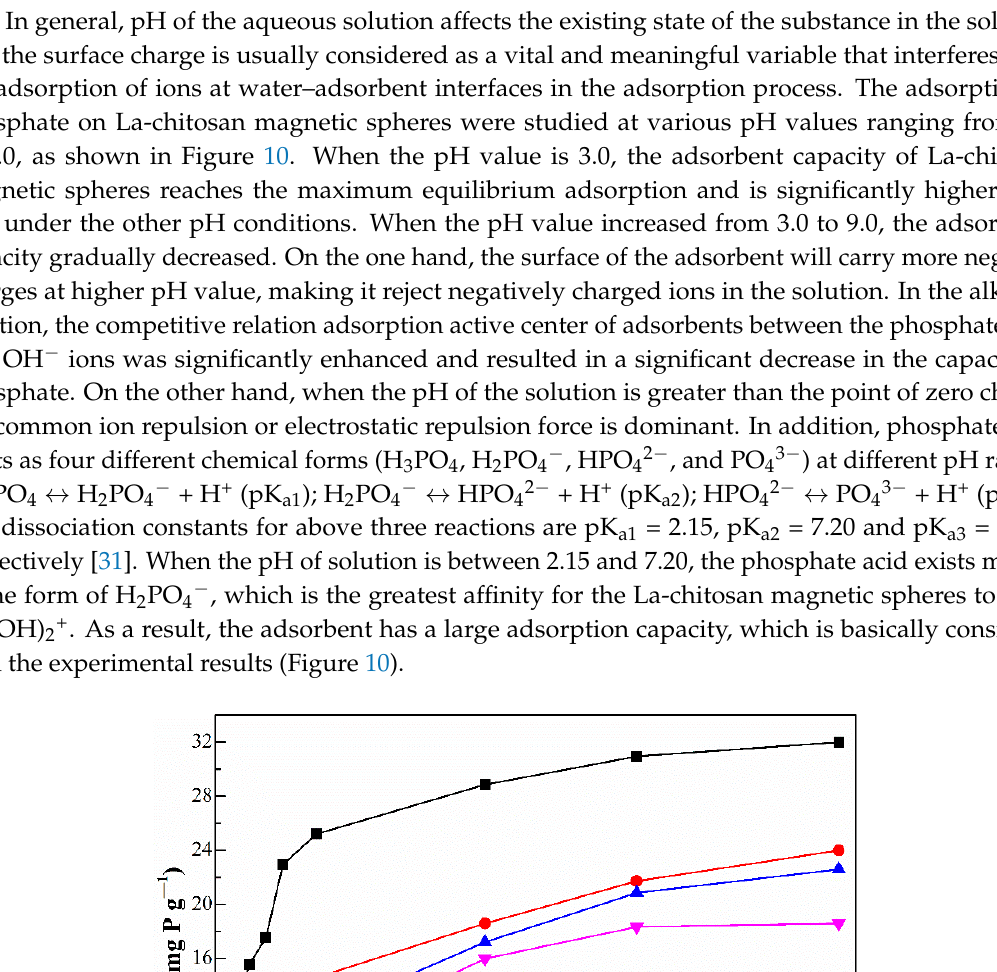
Figure 11. Effect of coexisting anions on the phosphate adsorption capacity of La-chitosan magnetic spheres.